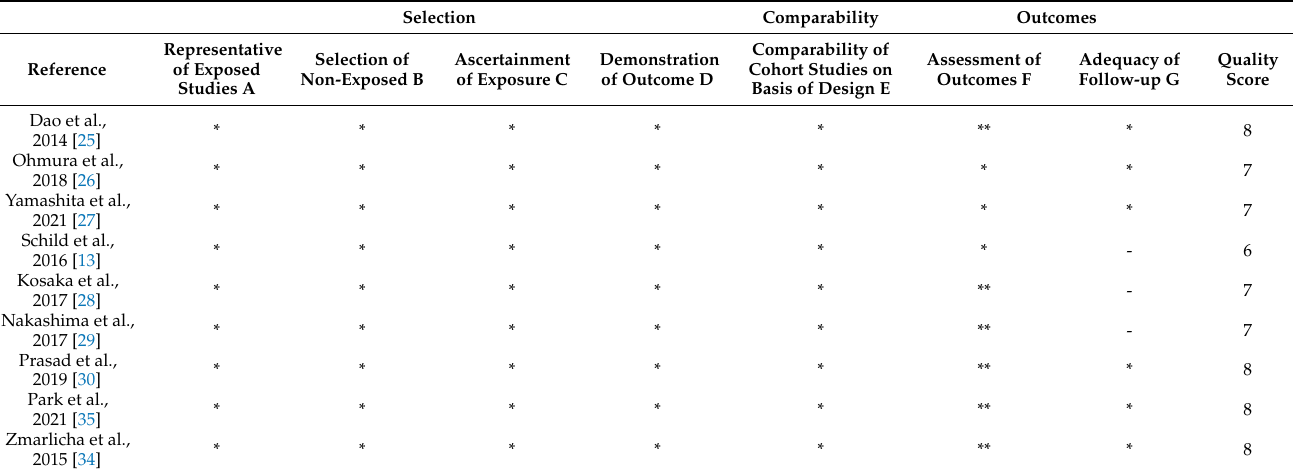
Table 2. Quality assessment of cohort